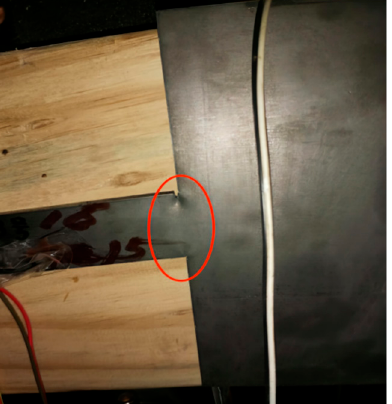
Figure 7. Crack in energy dissipation section of metallic damper.